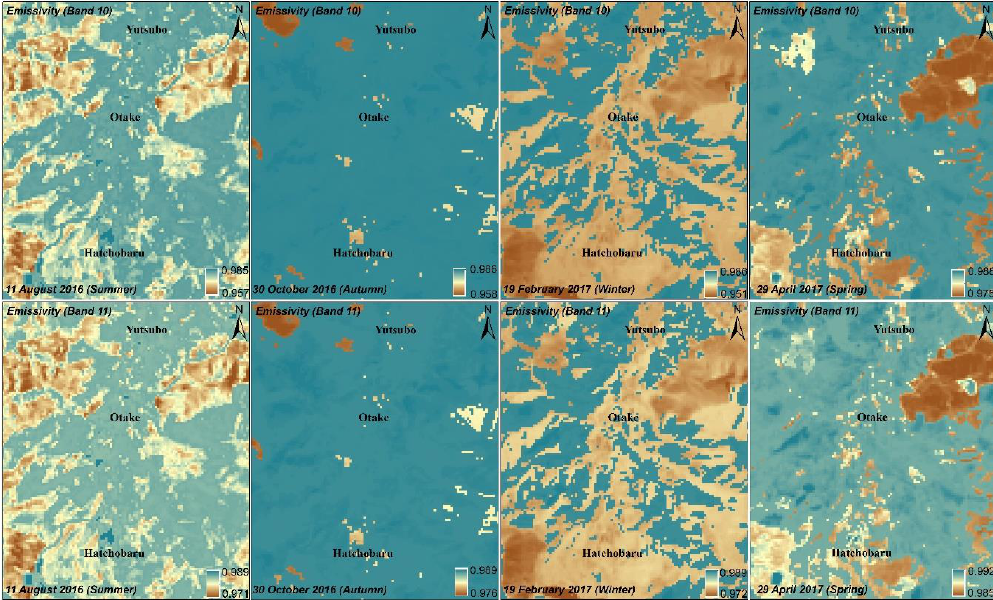
Figure 12. Emissivity values for the study area in each season. The emissivity values derived from Landsat 8 band 10 are shown in the ( top ) row, while the emissivity values derived from Landsat band 11 are shown in the ( bottom ) row. The season is shown along the bottom of each image.